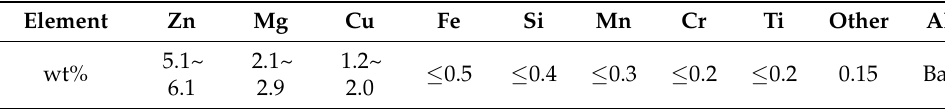
Table 1. Chemical composition of 7075 Al